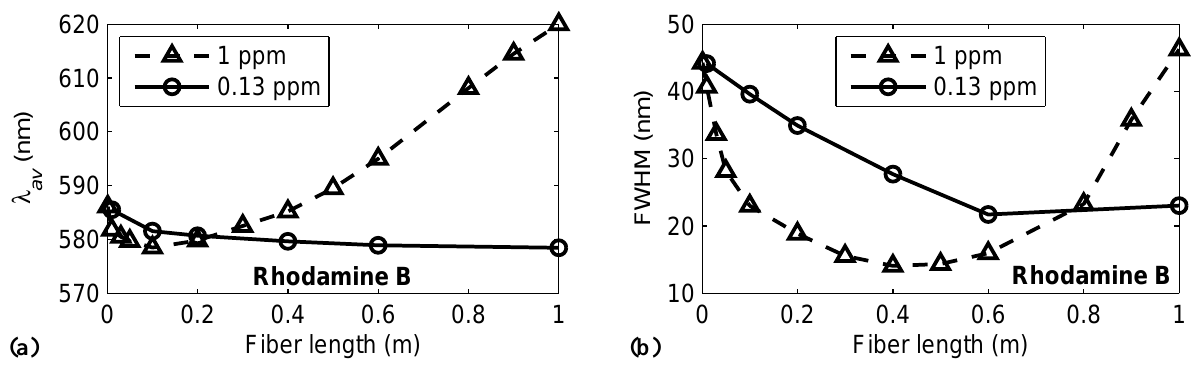
Figure 6. Evolution with distance of the average wavelength ( a ) and of the FWHM ( b ) for two different